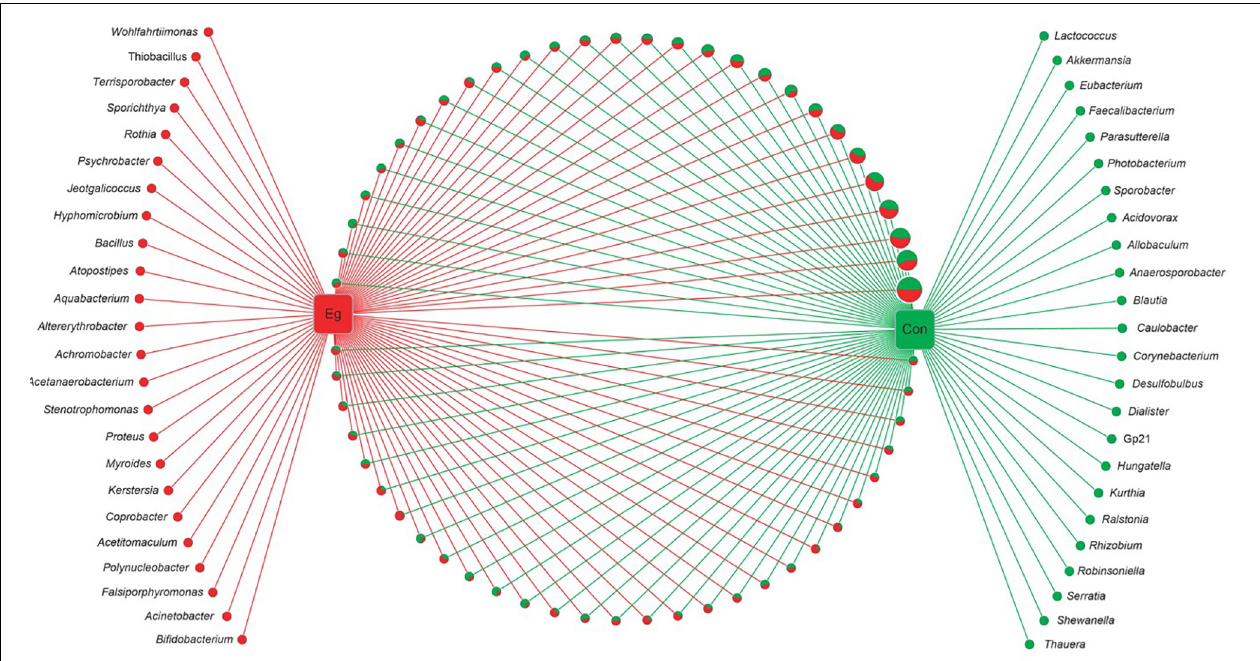
FIGURE 2 | Networks of all bacterial genera revealed in E. granulosus uninfected and infected animal groups. Green circle: the unique genera of the Uninfected Group; red circle: the unique genera of Infected Group. In pie charts, green and red represents the genus proportion of the uninfected and infected animal groups; all the pie charts present all the genera common in both groups. Circle sizes represent the read numbers.